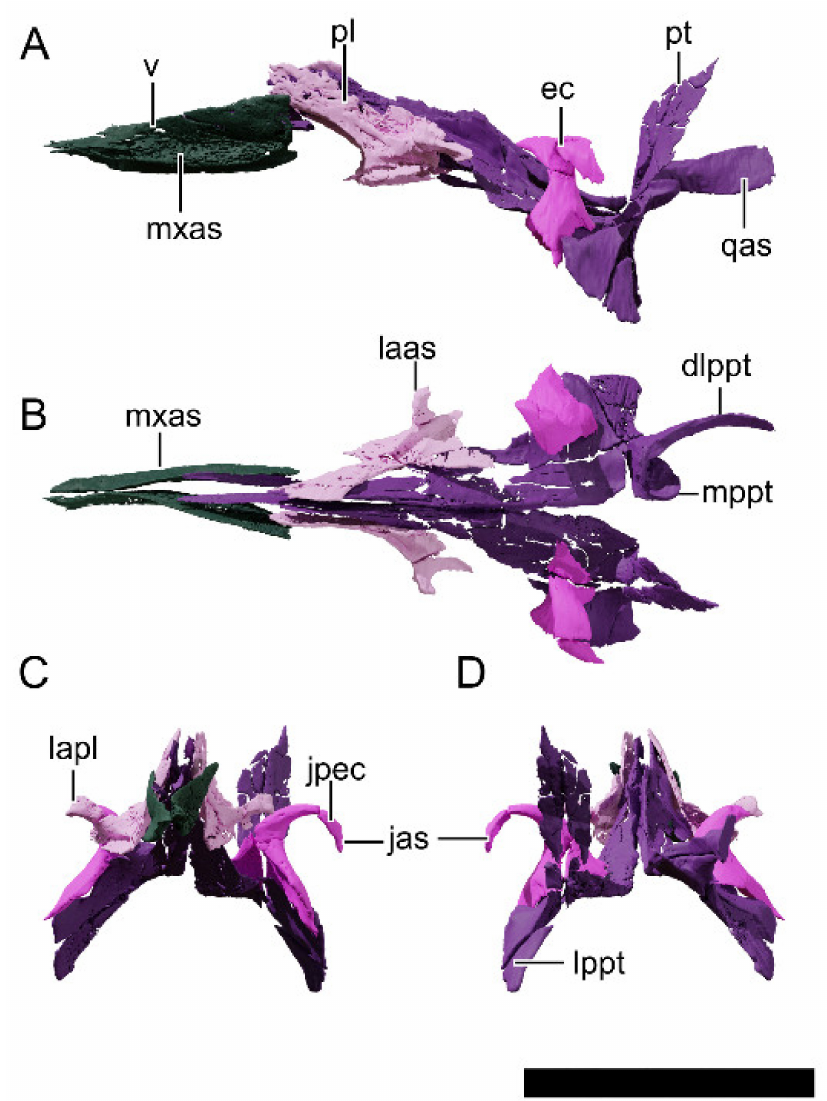
Figure 26. Digital reconstruction of the palate of NHMD 164758. ( A ) Left lateral view. ( B ) Dorsal view. ( C ) Anterior view. ( D ) Posterior view. The elements were articulated digitally for the reconstruction. Abbreviations: dlppt, dorsolateral process of the pterygoid; ec, ectopterygoid; ecf, ectopterygoid fossa; jas, articular surface for the jugal; jpec, jugal process of the ectopterygoid; laas, articular surface for the lacrimal; lapl, lateral process of the palatine; lppt, lateral process of the pterygoid; mppt, posteromedial process of the pterygoid; mxas, articular surface for the maxilla; pl, palatine; pt, pterygoid; qas, articular surface for the quadrate; v, vomer. Scale bar = 20